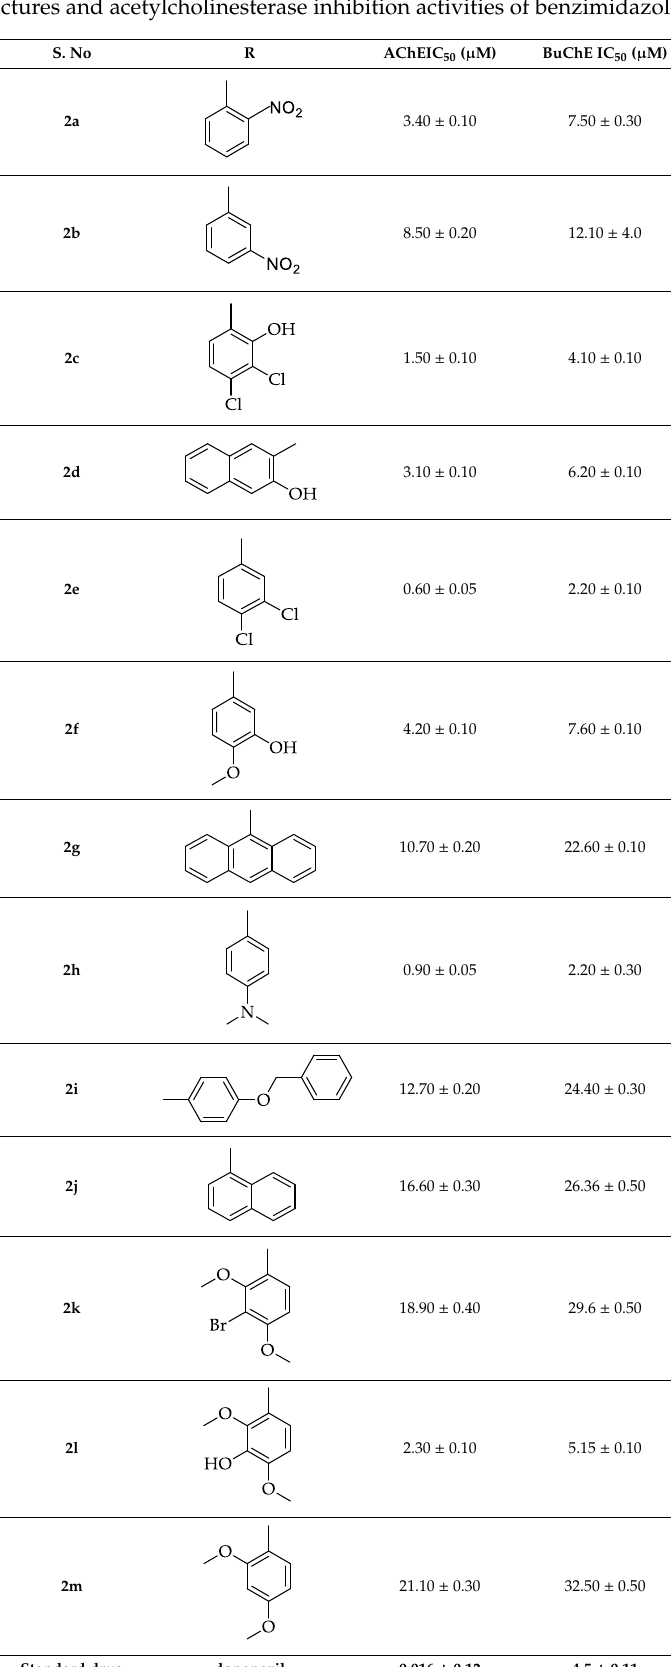
Table 2. Structures and acetylcholinesterase inhibition activities of benzimidazole Schiff bases.